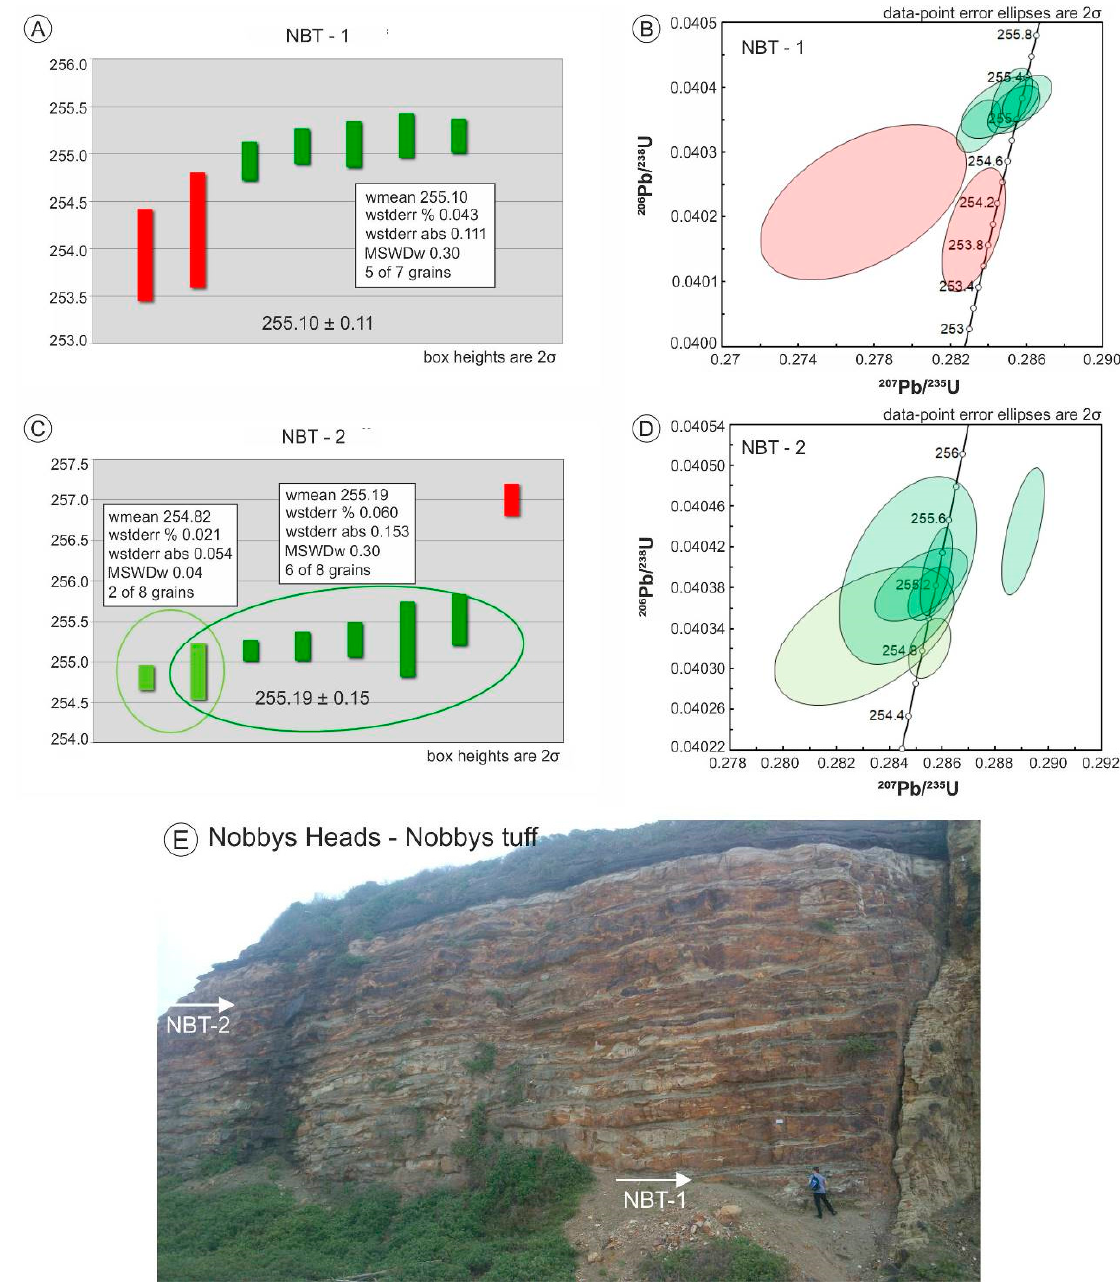
Figure 6. Weighted mean U-Pb CA-IDTIMS results of the selected samples in the study region (northern Sydney Basin). ( A ) to ( D ). Obtained zircon ages and Concordia plots of the tuff marker beds exposed at Nobbys heads. ( E ) Outcrop photograph of the studied location illustrating the stratigraphic position of the selected tuff samples. Person for scale is 180 cm tall. Plots illustrate individual zircons (green) used in weighted mean calculation and rejected zircon ages (red). Uncertainties are 2 σ internal.